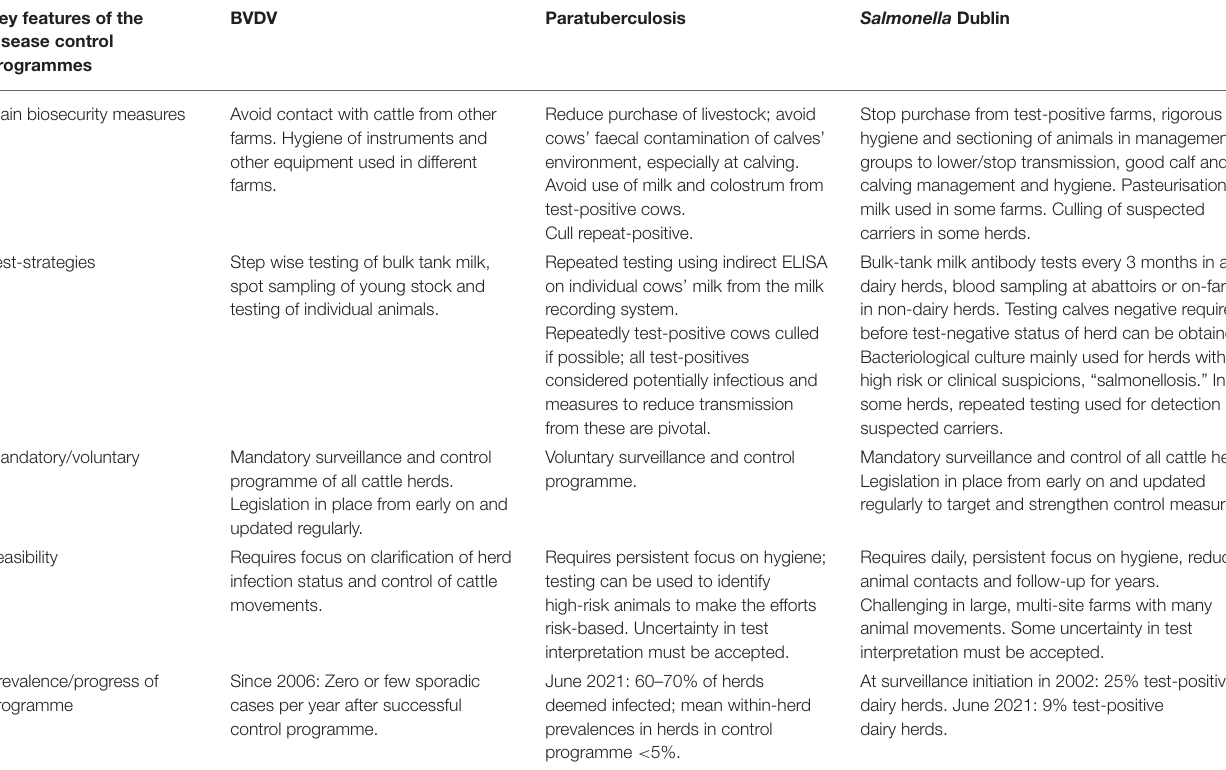
TABLE 2 | Overview for comparison of key features and progress of control programmes for BVDV, paratuberculosis and Salmonella Dublin in Danish dairy cattle farms up until June 30, 2021 (i.e., the information is non-exhaustive). Key features of the disease